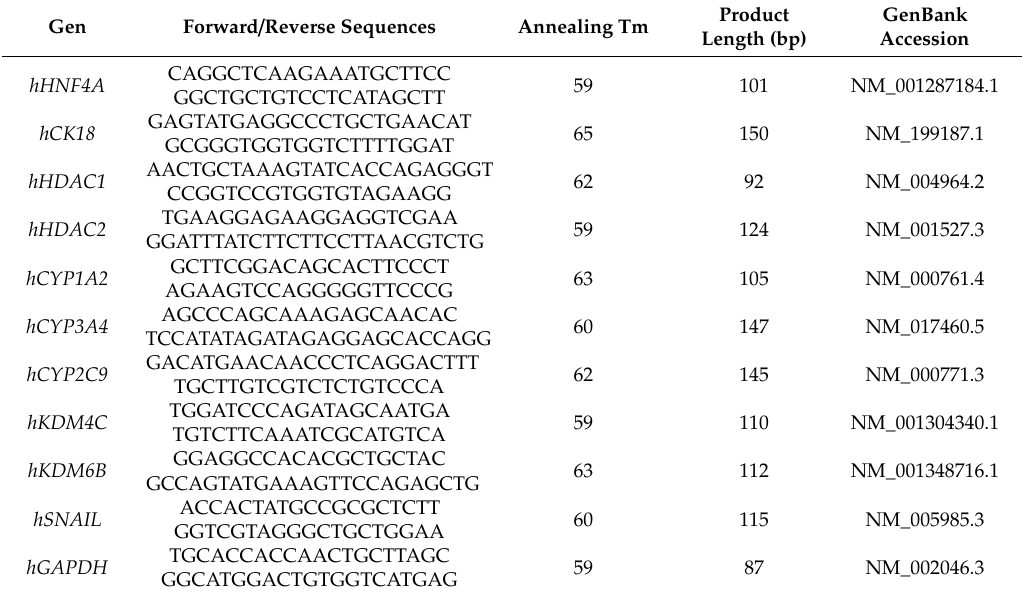
Table 3. Primers which were used for